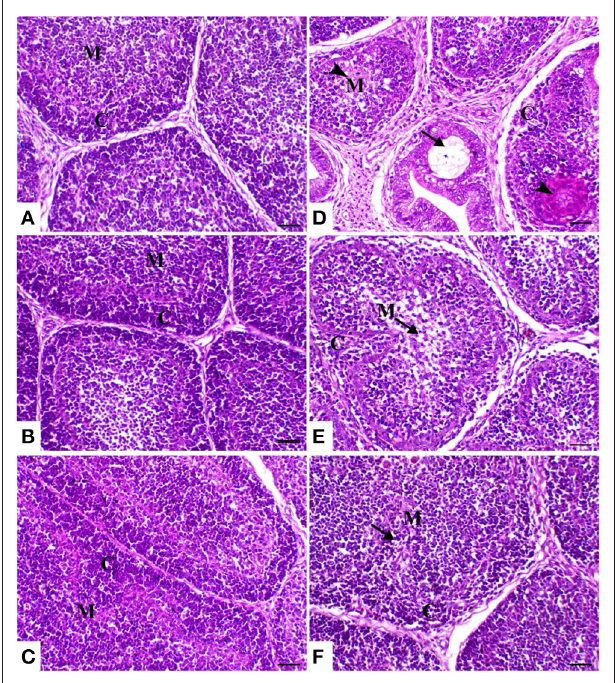
FIGURE 3 | Splenic sections of the different treated groups. (A) Spleen of the control group showing normal lymphoid follicles (M and C indicate the medulla and cortex of the lymphoid follicle, respectively). Sham groups (B) R and (C) E revealing normal lymphoid follicles. (D) Spleen of the heat stress (HS) group showing marked lymphoid necrosis and histocytic cell proliferation. (E) Spleen of the HS + R showing a marked decrease of histocytes and a slight degree of lymphoid depletion. (F) Spleen of the HS + E showing a marked increase of lymphoid elements within the follicle. H&E, × 200, bar = 50 µ m.